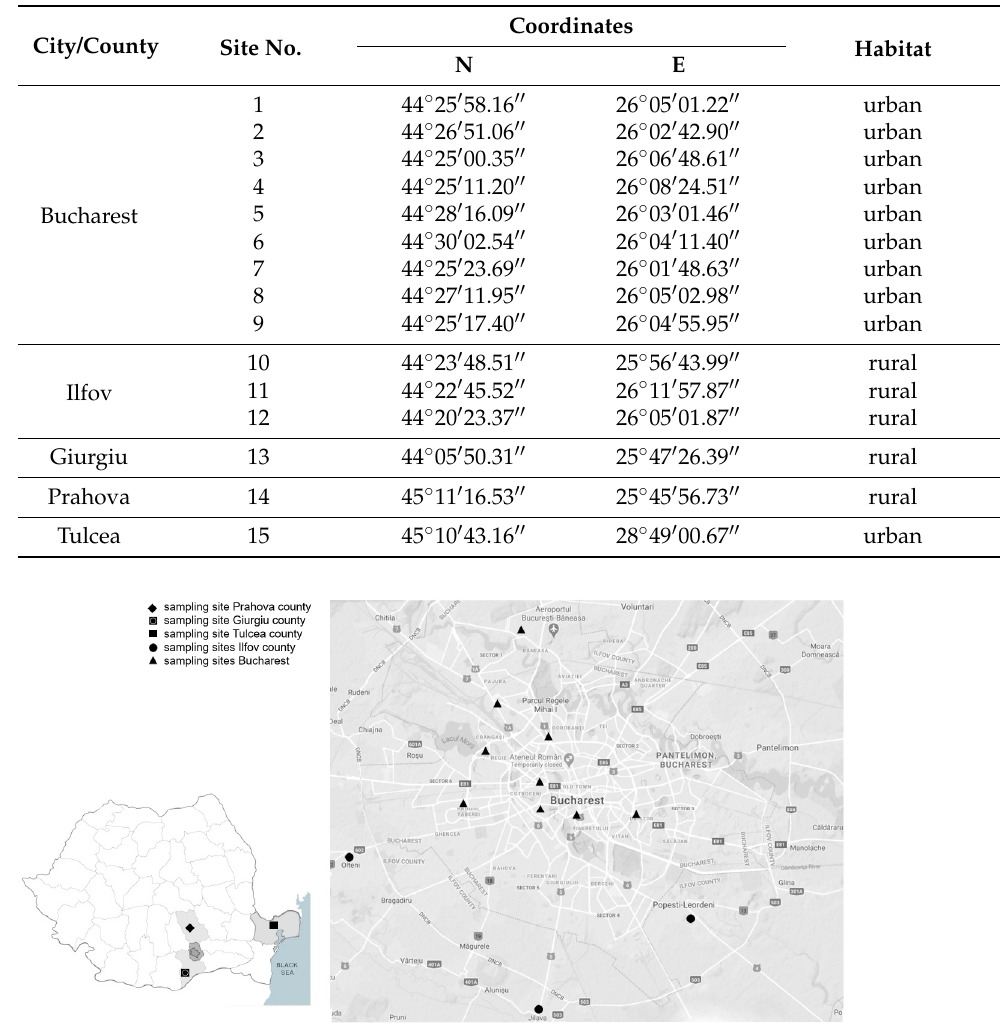
Table 1. Mosquito sampling sites, south-eastern Romania, 2018–2019.